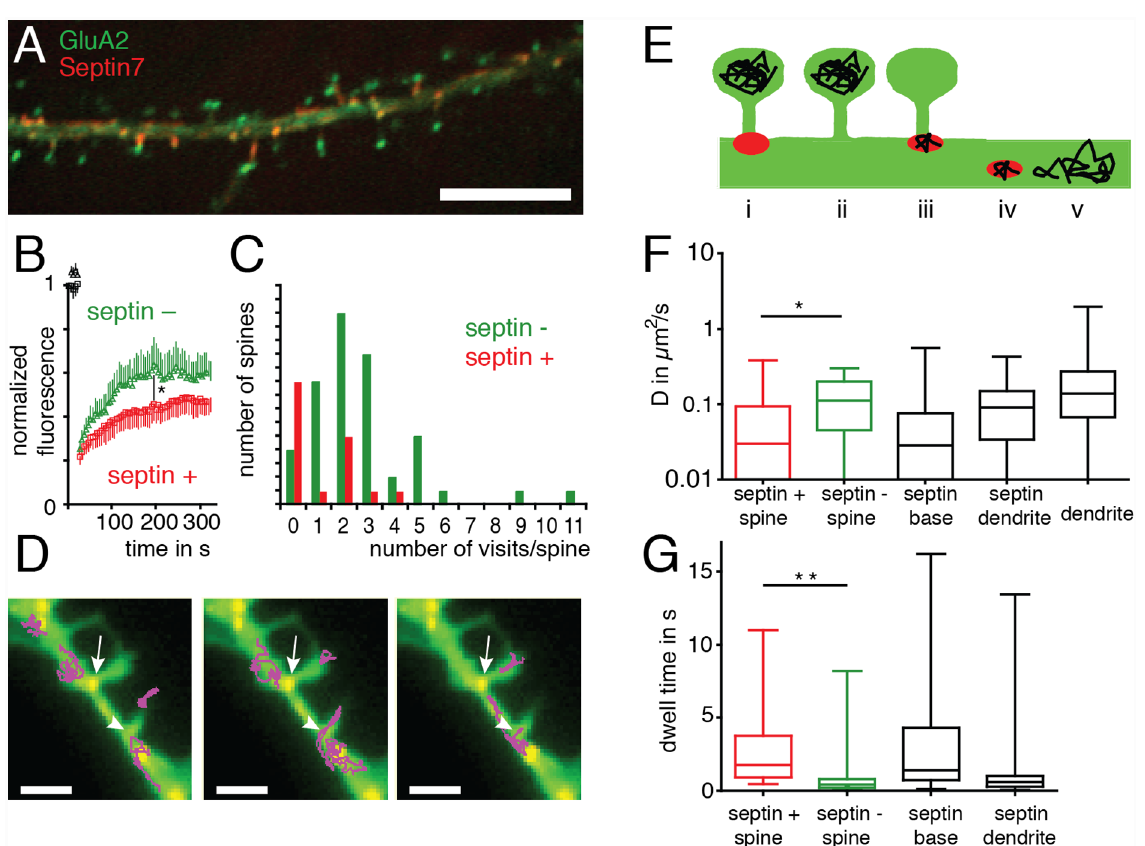
Fig. 3. Membrane-dynamics of GluA2 in respect to Sept7 localization to spine necks. (a) Fluorescence microscopy image of a region of interest from a DIV 10 + 2 hippocampal neuron transiently expressing GluA2-SEP and Sept7-mOrange2. GluA2-SEP staining is enriched at the tip of dendritic spines, whereas Sept7-mOrange2 positive areas are found at the spine base. Scale bar is 10 m m. (b) Quantification of GluA2 fluorescence recovery in Sept7-GFP- positive (red squares) and Sept7-GFP-negative spines (green triangles). More than 10 spines from more than three independent experiments are utilized. (p 5 0.0165) (c) Quantification of spine visits by GluA2-coupled quantum dots. An event is the crossing of the constricted area of the spine neck in the direction into the spine head area. Red bar: Sept7-GFP positive spines, green bar: Sept7-GFP negative spines. Shown is a statistic of all spines that bore mobile receptors in more than 30 movies from n . 15 neurons. (d) Trajectories of single GluA2-coupled quantum dots from a single particle tracking experiment overlaid over a fluorescence image of the corresponding neuron. mRFP pseudocolored green, Sept7-GFP pseudocolored red, trajectories in magenta. Scale bar is 5 m m. (e) Classification of subcellular regions within dendrites for single particle tracking analysis from left to right: (i) the heads of spines that have Sept7-GFP staining at their necks. (ii) the heads of spines without Sept7-GFP at their neck. (iii) Sept7-GFP positive regions at spine bases, (iv) Sept7-GFP positive regions on the dendrite and (v) in Sept7-GFP free regions on the parent dendrite. (f) Analysis of GluA2-QD trajectories according to the diffusion coefficient. The median diffusion is reduced in Sept7-GFP positive spines compared with Sept7-GFP negative spines (bar: median ¡ 25–75% interquartile range, line: spread of data), *p , 0.05, Mann-Whitney test. (g) Dwell time of GluA2 coupled QDs in different regions of the cell. The median dwell time is longer in Sept7-GFP positive spines (0.03 s) than in Sept7-GFP negative spines (0.11 s) (bar: median ¡ 25–75% interquartile range, line: spread of data), **p , 0.01, Mann-Whitney test. Shown are experiment performed in 3 cultures in 32 cells with a total of 286 QDs.